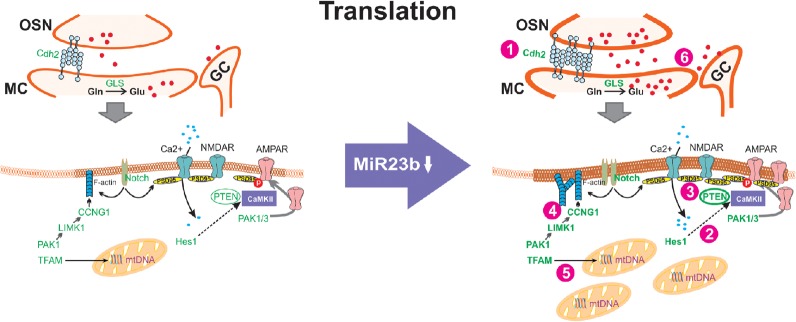
Model of functional alterations associated with the protein translation increases predicted by down-regulating MiR23b in the dorsolateral mitral cells of the olfactory bulb in learning versus nonlearning pups. Genes highlighted in green are also in mitral cells in mice in this age range (Developing Mouse Brain Atlas). Functional changes include (1) increases in cell adhesion, (2) increases in AMPA receptors, (3) modulation of NMDA receptors, (4) increases in the synaptic membrane and actin branching, (5) increases in mitochondrial biogenesis, (6) increases in neuronal glutamate synthesis. (OSN) olfactory sensory nerve, (MC) mitral cell dendrite, (GC) granule cell inhibitory interneuron dendrite, (Cdh2) cadherin2 or N-cadherin, (Gln) glutamine, (GL) glutamate, (GLS) glutaminase, (Ca2+) calcium, (NMDAR) NMDA receptor, (AMPAR) AMPA receptor, (mtDNA) mitochondrial DNA, (TFAM) Transcription Factor A Mitochondrial, (LIMK1) Lim-domain kinase, (CCNG1) cyclin G1, (F-actin) filamentous actin, (Notch) Notch Receptor, (PSD95) postsynaptic density protein 95, (Hes1) Hairy enhancer of split protein1, (PTEN) Phosphatase and tensin homolog deleted on chromosome 10, (PAK1 and PAK1/3) Serine/Theronine-activated p21 kinases, (CaMKII) calmodulin kinase II, (P) phosphate.